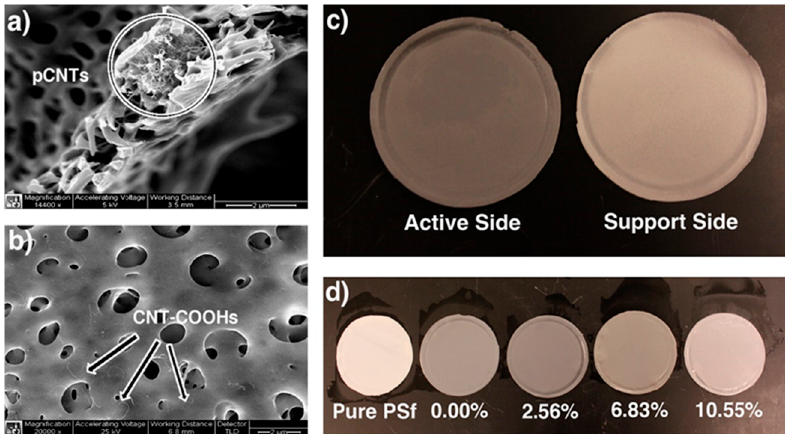
Figure 12. ( a ) Cumulated pristine MWCNTs inside the cross-section of a PSf membrane. ( b ) Well- dispersed and functionalized CNT-COOHs (7.97%) all over the polymer membrane. ( c ) The darker color of the active side compared to that of the support side. ( d ) The membrane color is an indicator of the compatibility of PSf with CNTs in different ratios of carboxylation (on left only PVP and PSf, others are nanocomposites with 0.5 wt% CNTs). With permission [52].